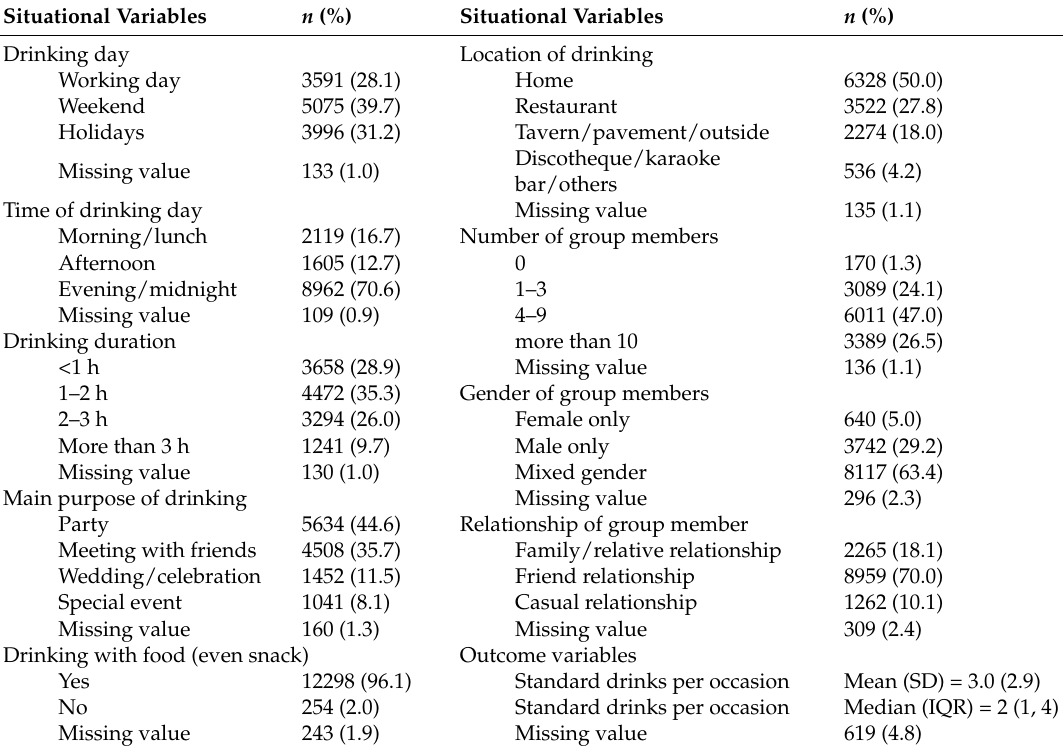
Table 2. Situational characteristics of 12,795 drinking occasions among 12 universities/faculties in four provinces in